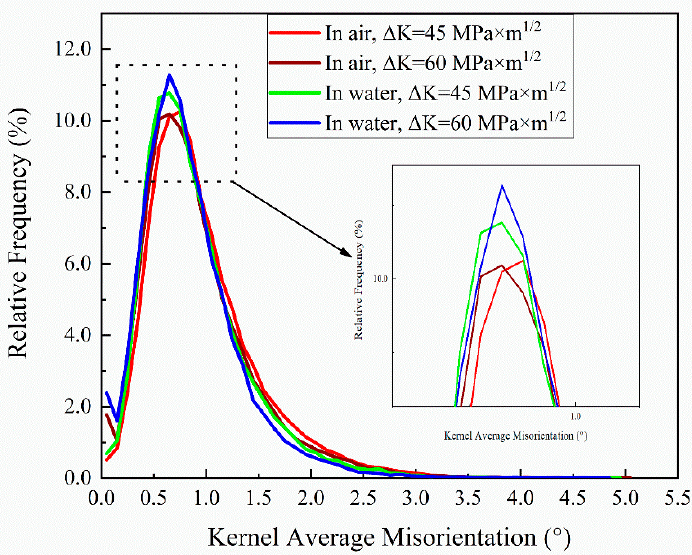
Figure 16. KAM distributions in X80 steel welded joints.